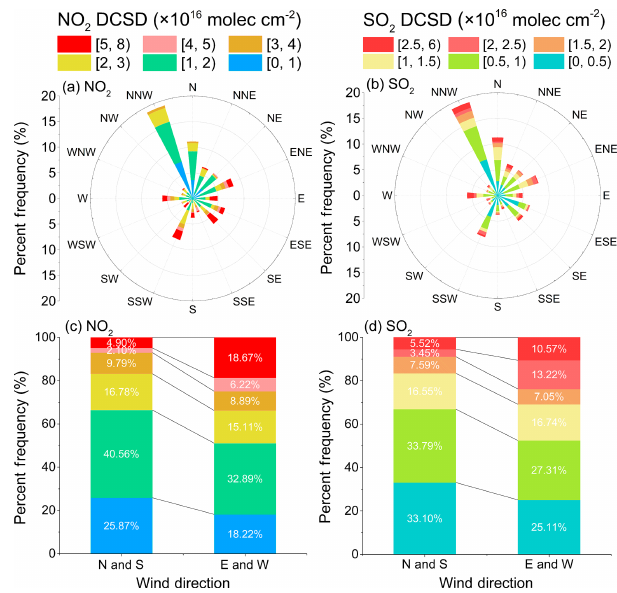
Figure 8. The dependence of NO 2 (a, c) and SO 2 (b, d) DSCDs at an elevation of 5 ◦ on wind directions from January to March 2018.